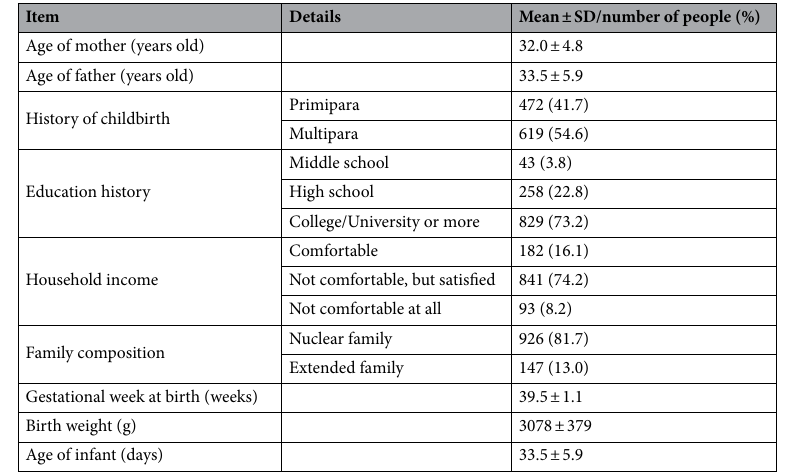
Table 1. Basic characteristics of the study population.